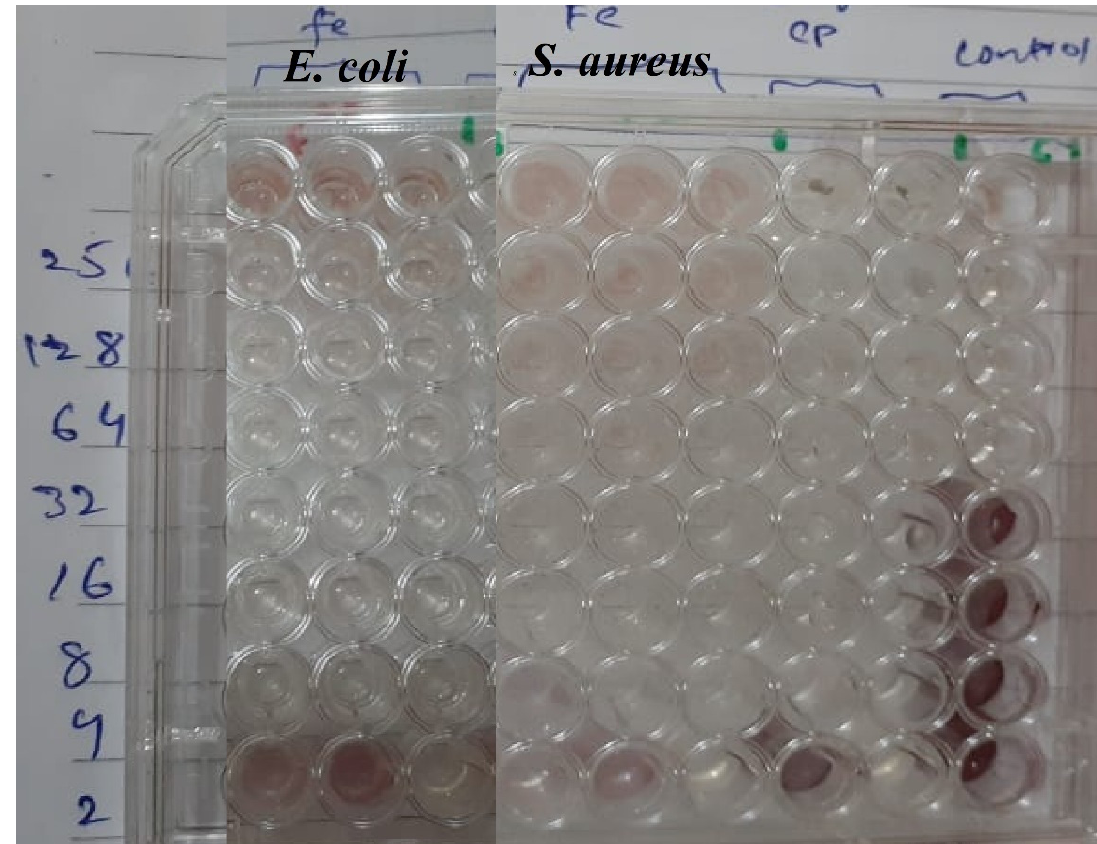
Figure 4. Minimum inhibitory concentration of Fe 2 O 3 NPs against S. aureus and E. coli.